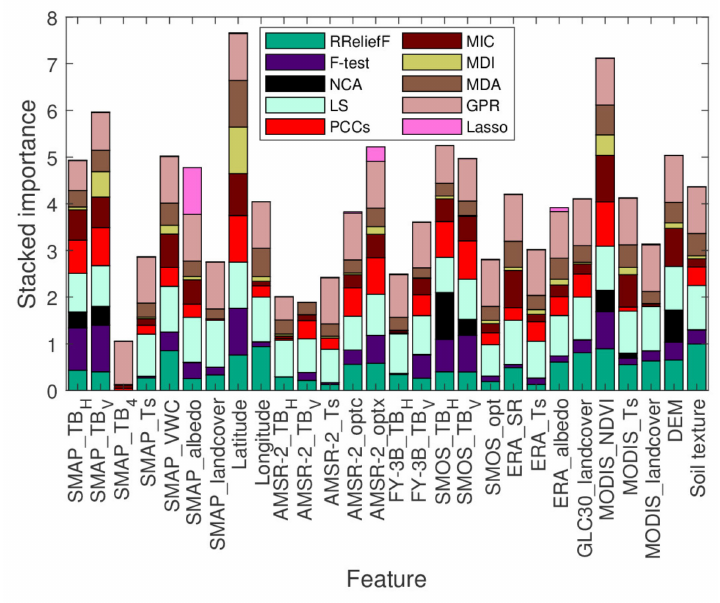
Figure 3. Stacked bars of feature importance obtained by different feature selection methods.